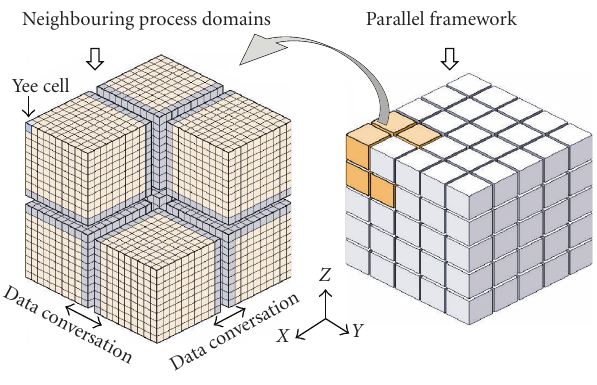
Figure 1: Schematic representation of a parallel network with 125 process domains; transmission of field data between neighbouring processes is